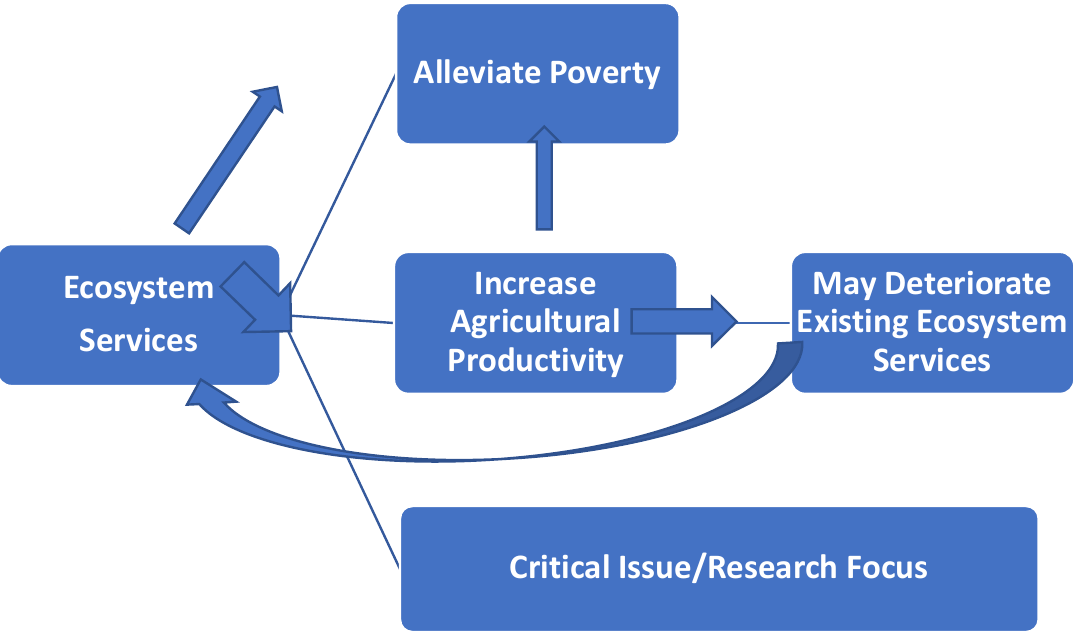
Figure 1. The trade-offs in the “ménage à trois” among ESs, poverty alleviation, and agricultural productivity.